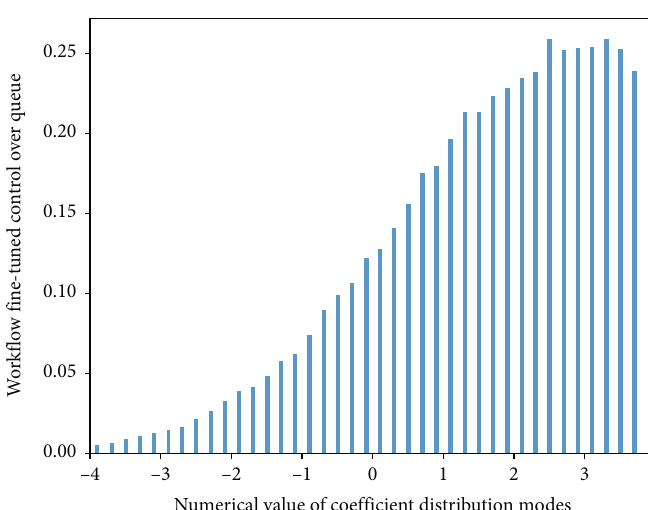
Figure 6: Work fl ow fi ne control coe ffi cient